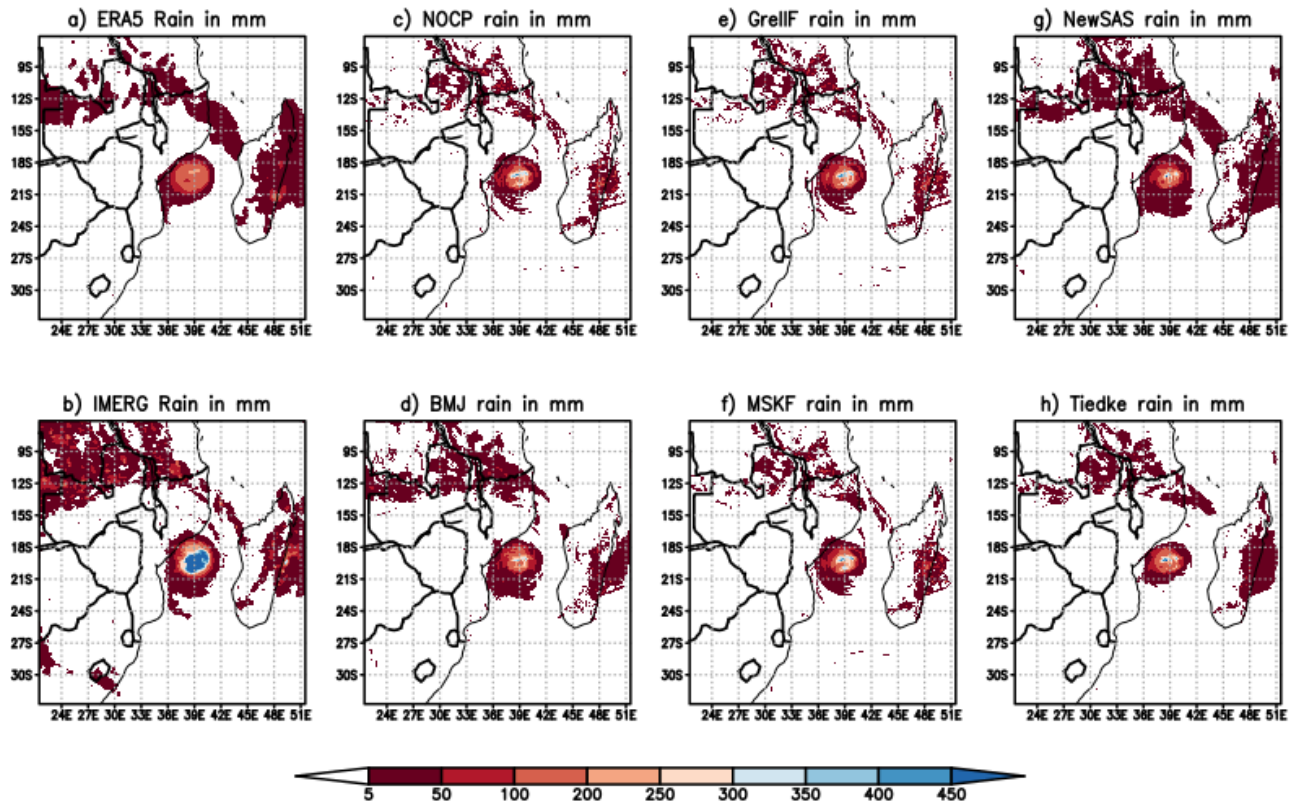
Figure 3. Accumulated rainfall (mm) for 13 March from ( a ) ERA5, ( b ) IMERG, and WRF simulations with ( c ) no-convection scheme, ( d ) the BMJ scheme, ( e ) the Grell–Freitas scheme, ( f ) the MSKF scheme, ( g ) the NewSAS scheme and ( h ) the new Tiedtke